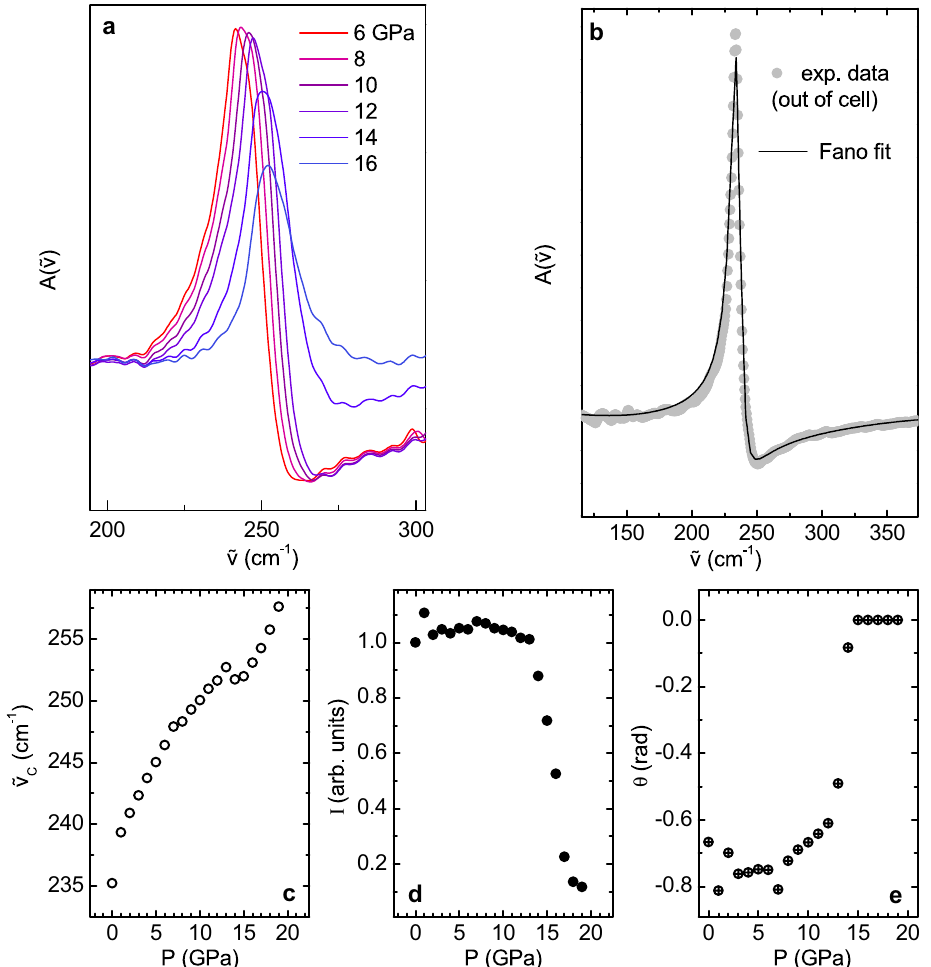
Figure 3. ( a ) Absorbance spectra at selected pressures after the subtraction of a parabolic background and of sinusoidal fringes. ( b ) Experimental data at ambient pressure (dots) fitted by a Fano function (continuous line): ν 2 cos θ ν( ν 2 ν 2 C ) sin θ F ( F ν) ˜ + ˜ ˜ − ˜ . ( c ) E 1 u peak position ˜ = · ν 2 γ 2 ( ν 2 ν 2 C ) ˜ + ˜ − ˜ function of pressure, normalized to the 1 GPa value. ( e ) θ parameter of the Fano fit as a function of